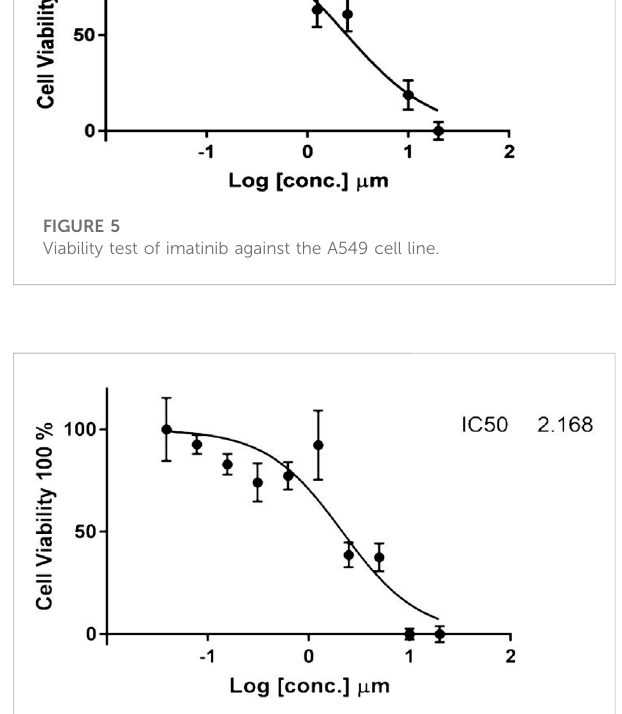
FIGURE 6 Viability test of compound IIA against the A549 cell line.